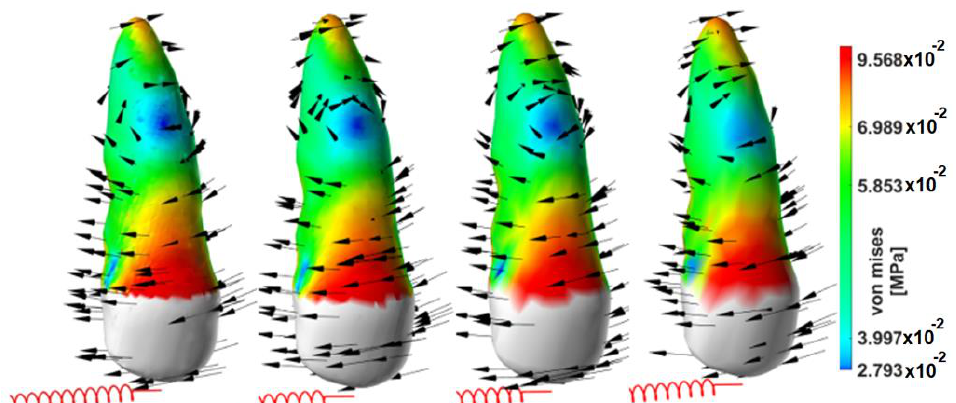
Figure 5. Facet number optimization as OTM initiated (before remodeling started) over a molar tooth. The red spiral represents the external force.